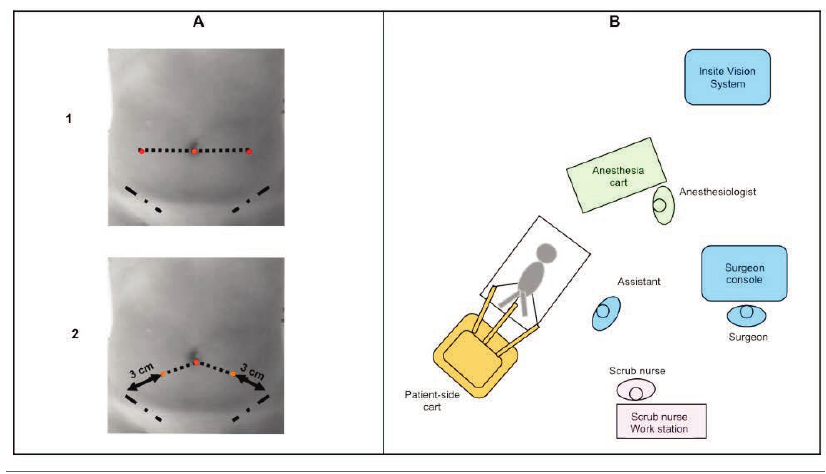
Figure 1. Room setup schematic for gynecological procedures. Panel A: trocar positioning in small children (<8 years, Panel A1) and in children (>8 years, Panel A2) and adoles- cents. Panel B: position of the surgical staff and robot